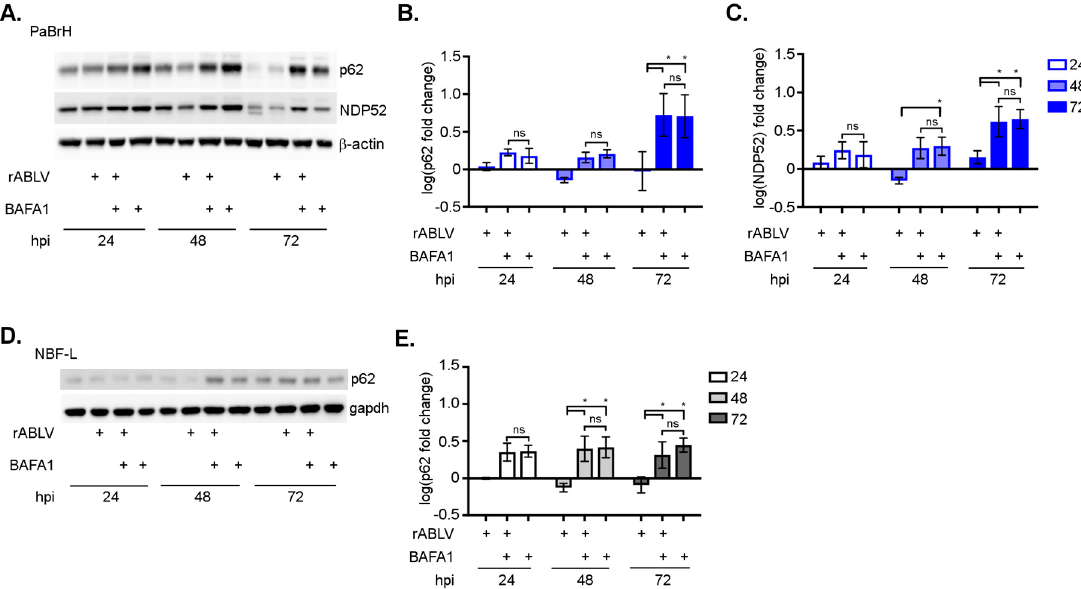
Figure 5. ABLV infection does not inhibit autophagic flux. ( A ) Western blot for p62 and NDP52 proteins in PaBrH cell lysates, rABLV-GFP (MOI 1.0), and BAFA1 (400 nM; 2 h). ( B ) Log transformed fold change of p62 protein (PaBrH) normalized to β -actin and compared to uninfected DMSO-mock treated time point controls. ( C ) Log transformed fold change in NDP52 protein (PaBrH) normalized to β -actin and compared to uninfected DMSO-mock treated time point controls. ( D ) Western blot for p62 in NBF-L cell lysates. ( E ) Log transformed fold change in p62 (NBF-L) normalized β -actin and compared to uninfected DMSO-mock treated time point controls. All data are representative of three independent experiments, mean ± SEM, * ANOVA (two-way), and Tukey’s multiple comparison test.